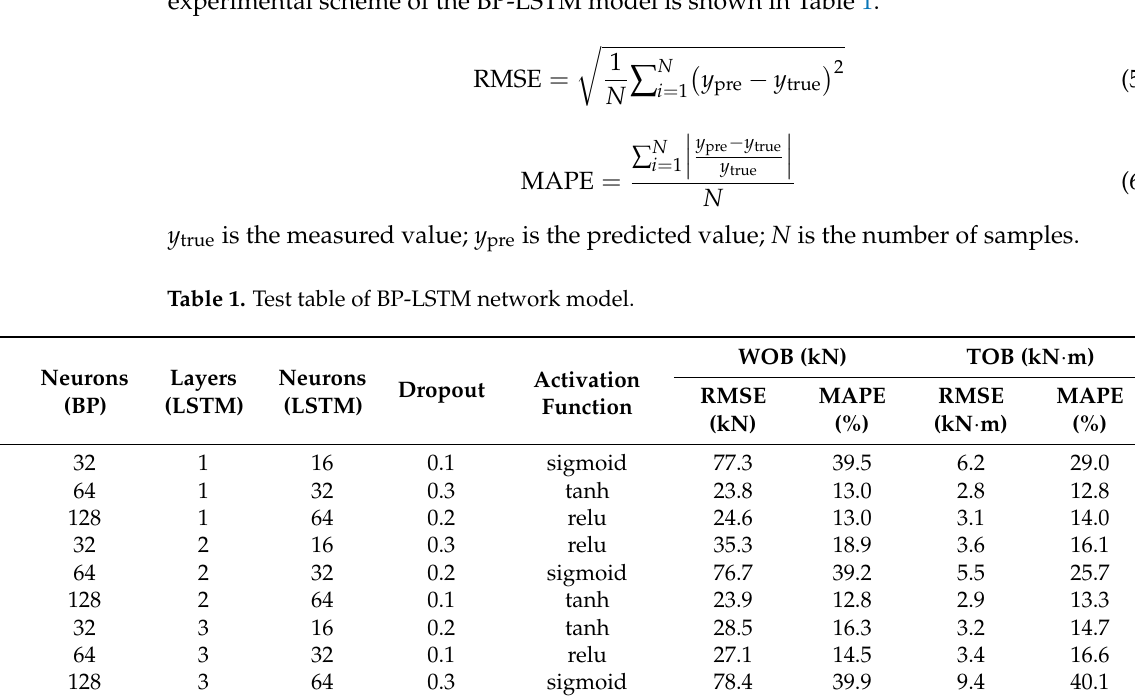
Table 1. Test table of BP-LSTM network model.